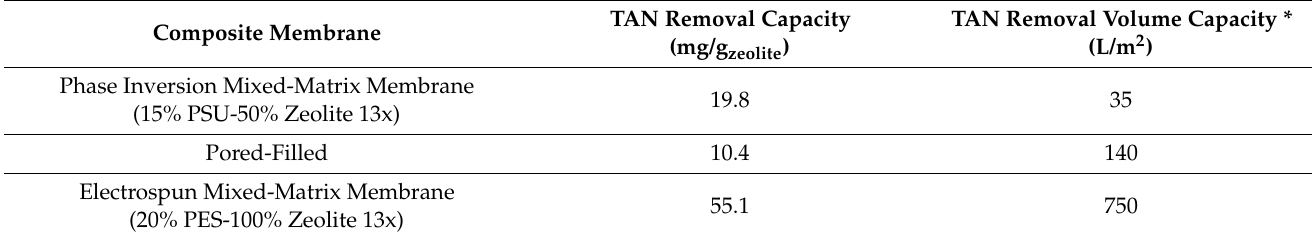
Table 4. TAN removal capacity comparison among three different mixed-matrix membranes. Composite